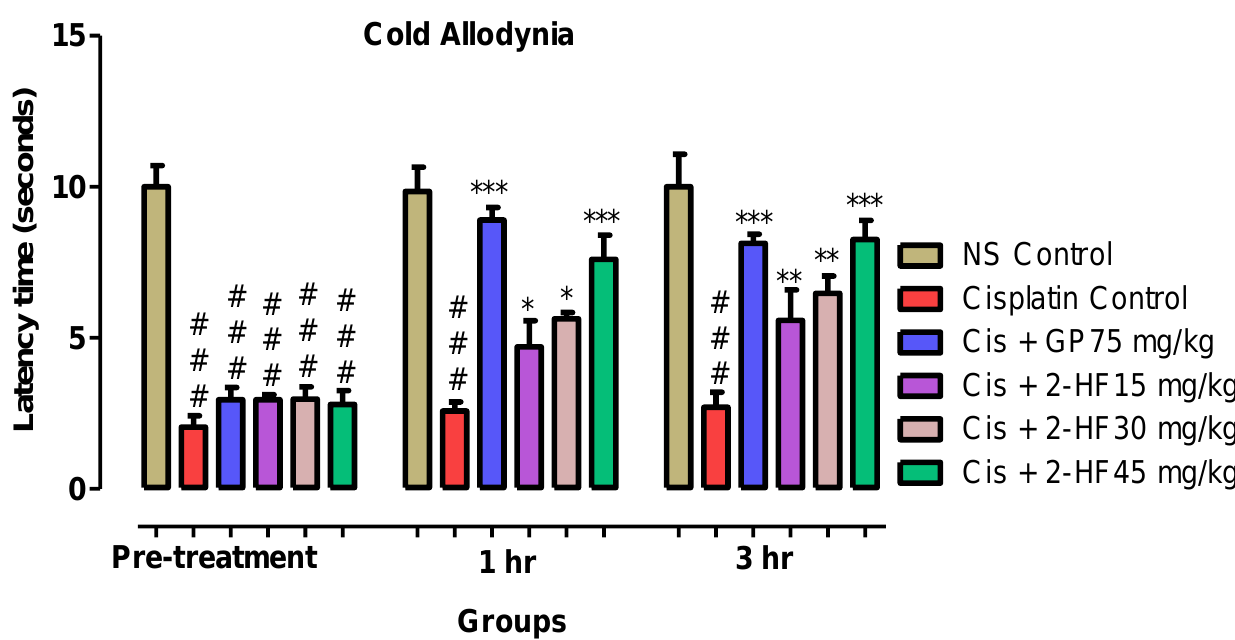
Figure 11. Results of acetone-induced cold allodynia study. Results are mean ± SEM ( n = 6). *** p < 0.001, ** p < 0.01, * p < 0.05 for standard GP + Cis, two-way repeated measures ANOVA followed